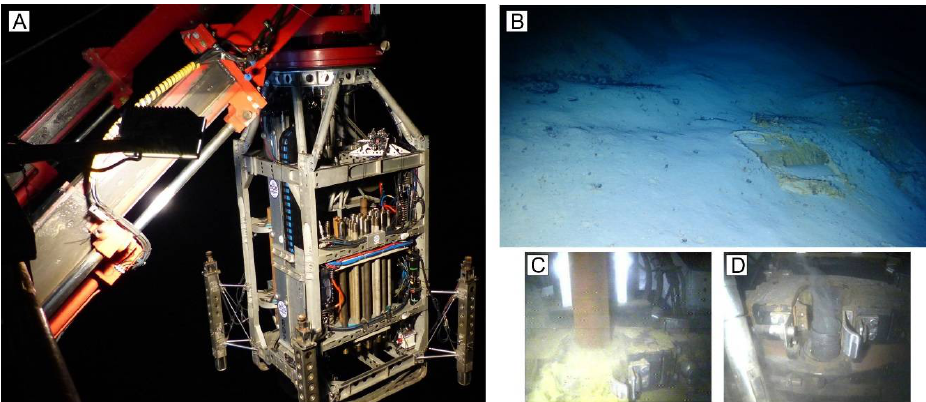
Figure 2. Photographs from the drilling campaign during JC138. ( A ) Deployment of BGS’s RD2 using its own launch and recovery system. ( B ) Footprints of the legs of RD2 on pelagic sediment covering Southern Mound. ( C ) Drilling at Rona Mound. ( D ) Sulfide-rich drill cuttings emanating from a borehole at MIR Zone.